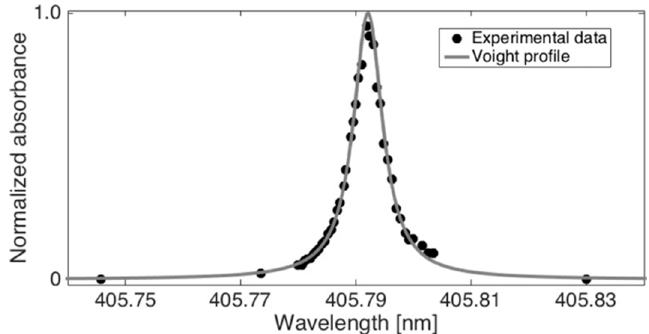
Figure 3. The absorption line of Pb* at 405.792 nm upon double photofragmentation of PbCl 2 . The profile was determined by measuring the absorbance as a function of the probe laser wavelength. The line represents a Voight profile obtained by fitting the experimental data (black dots).